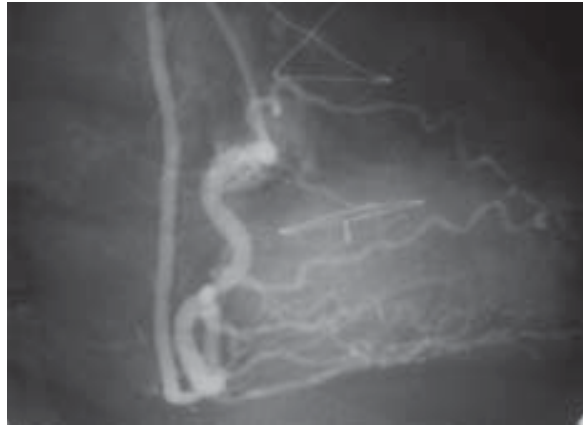
Fig. 3a - early restudy - 10 days after myocardial revascularization